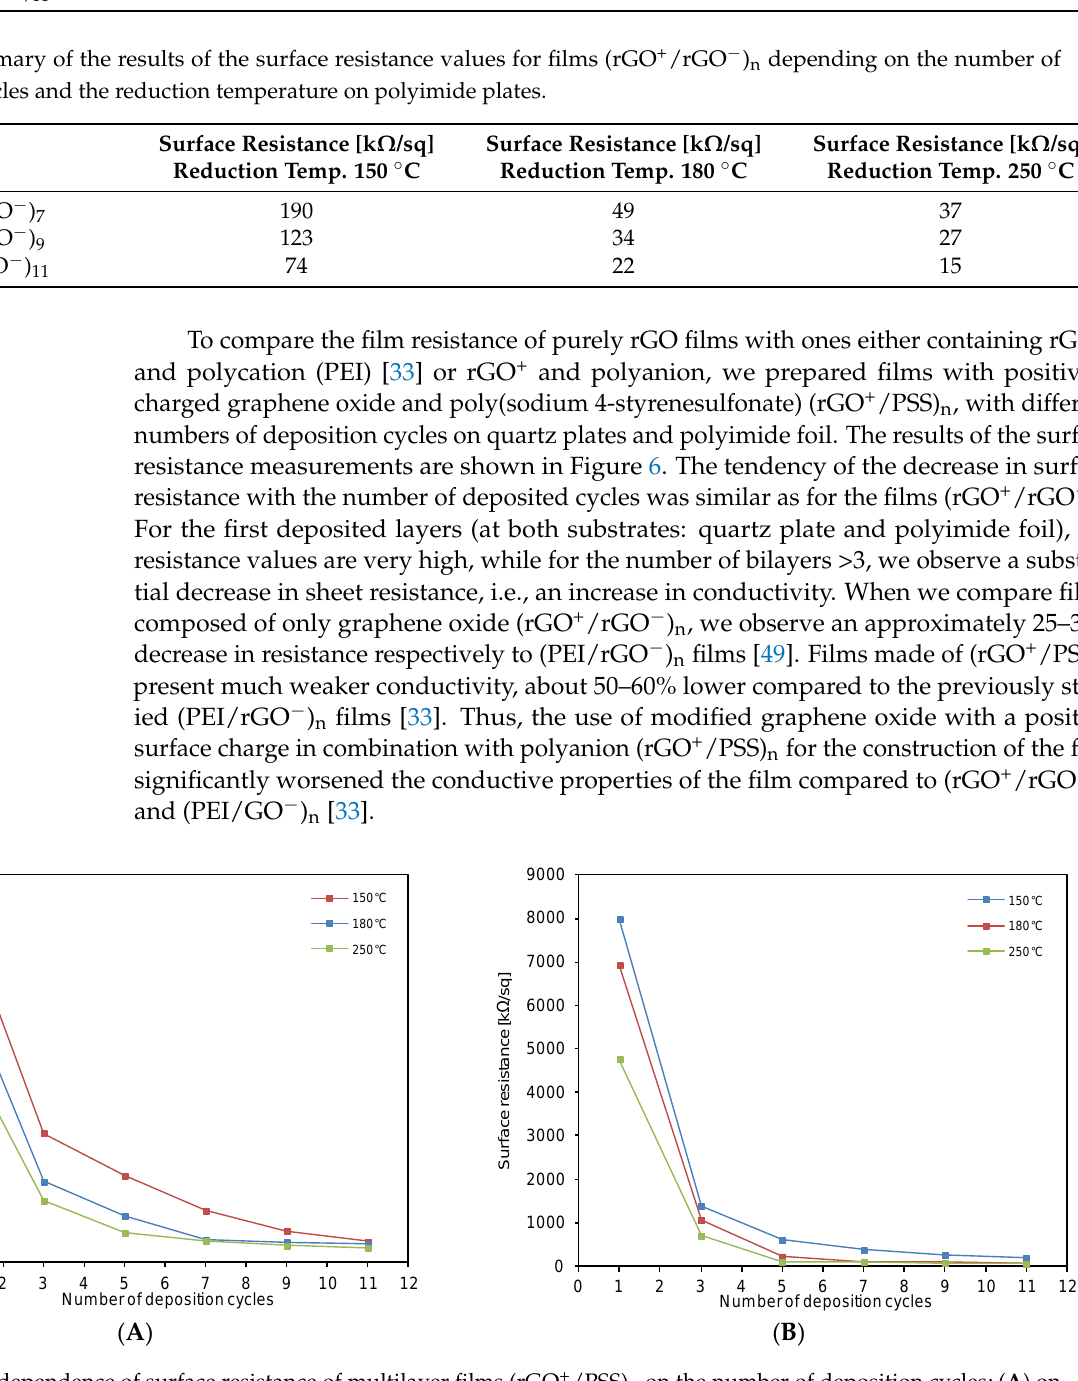
( B ) Figure 7. Dependence of the surface resistance values on the reduction temperature for (rGO + /PSS), (PEI/rGO − ), (rGO + /rGO − ) films formed by 11 deposition cycles on quartz plate ( A ) and polyimide foils ( B ). In Table 3, the surface resistance values were compared for the multilayer films de- posited on quartz plates, containing the comparable number of rGO layers, i.e., (rGO + /rGO − ) 5 , (PEI/rGO − ) 11 , and (rGO + /PSS) 11 . We can conclude that the decrease in film resistance per one rGO layer is higher when rGO − is combined in the multilayer with the polycation than with rGO + . PEI is a non-conductive polymer, but most probably, its flexi- bility allows more optimal packing of graphene flakes for higher conductivity. Moreover, there are reports on decreasing graphene work function by PEI [53]. On the other hand